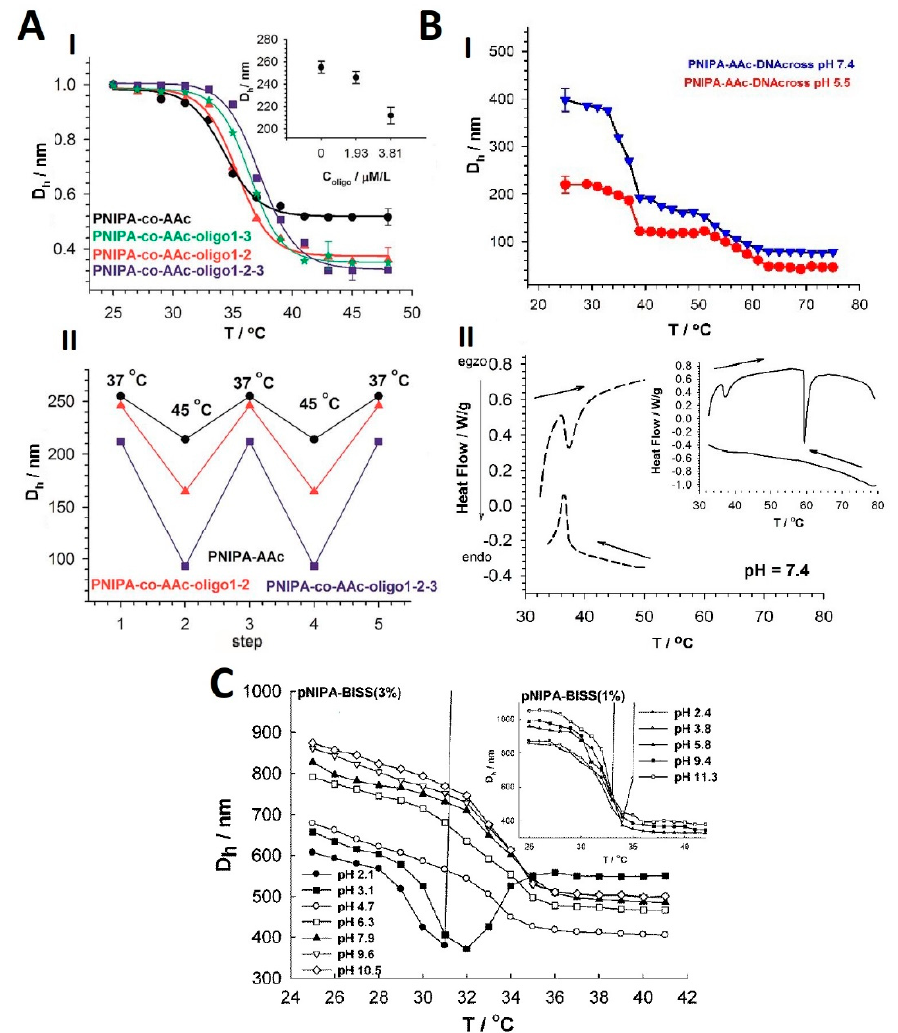
Figure 5. ( A ) The substantial movement of VPTT temperatures towards higher values after introducing of specific tri-segment structure of oligonucleotides to PNIPA-AAc based nondegradable NGs (PNIPA-co-AAc-oligo1-2-3 sample, I), significant reversibility of the size changes for hybrid oligonucleotide/PNIPA-AAc NGs contained tri-segment oligonucleotide structures in mild hyperthermia treatment (II), ( B ) the jumping VPTT changes recorded during degradation nanogel contained oligonucleotide-based crosslinkers (I), DSC plots recorded during degradation of oligonucleotide/PNIPA-AAc based nanogel hybrids (II), ( C ) Hydrodynamic diameter as function of temperature and pH for degradable, GSH responsive PNIPA-based microgel contained 3% of N,N - bisacryloylcystine (BISS) crosslinker. Reprinted from [51] and [50] and [76] with permission from the Royal Society of Chemistry, respectively.